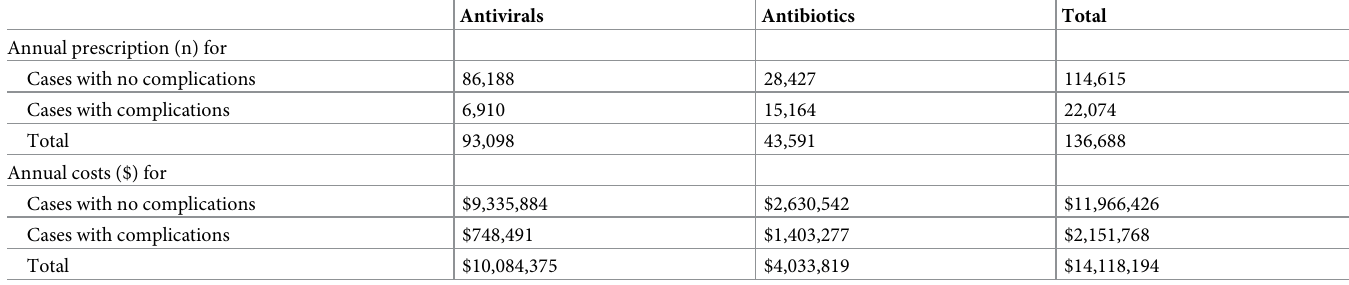
Table 2. Estimated total number of prescriptions and associated costs of antiviral and antibiotic use for the base case (Varicella cases with and without complications).